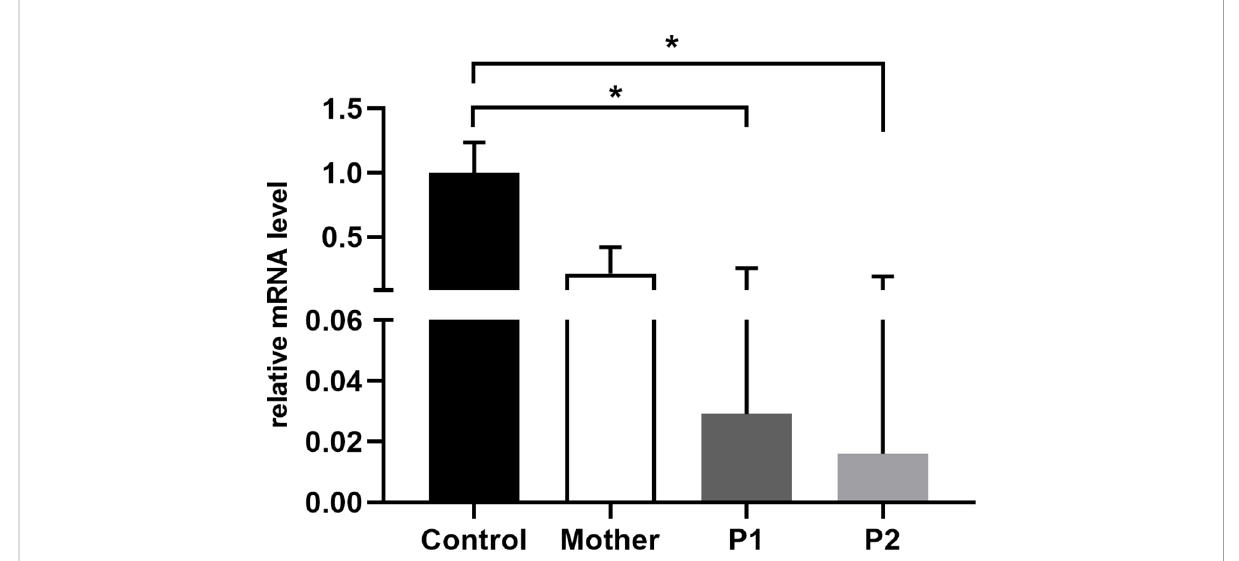
FIGURE 4 Relative quantity of MSN mRNA in PBMCs of healthy controls, mothers, and patients. Data are mean ± SEM for n = 4/healthy control and triplicates/mother, patients. * p < 0.05 control vs. mother, P1, and P2, based on one-way ANOVA followed by Bonferroni ’ s post-hoc